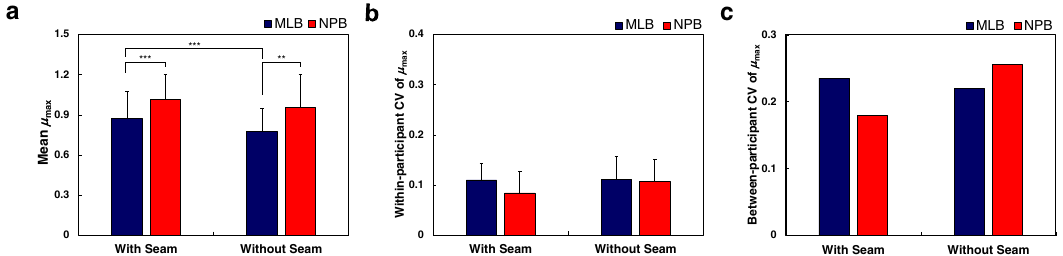
Fig. 6 Comparison of mean and CV values of the friction coef fi cient between MLB and NPB balls. a Mean µ max values for MLB and NPB ball with and without seam. b Mean CV values of µ max within participants for MLB and NPB balls with and without seam. c CV values of µ max between participants for MLB and NPB ball with and without seam. Error bar indicates standard deviation. ** p < 0.01, *** p < 0.001.